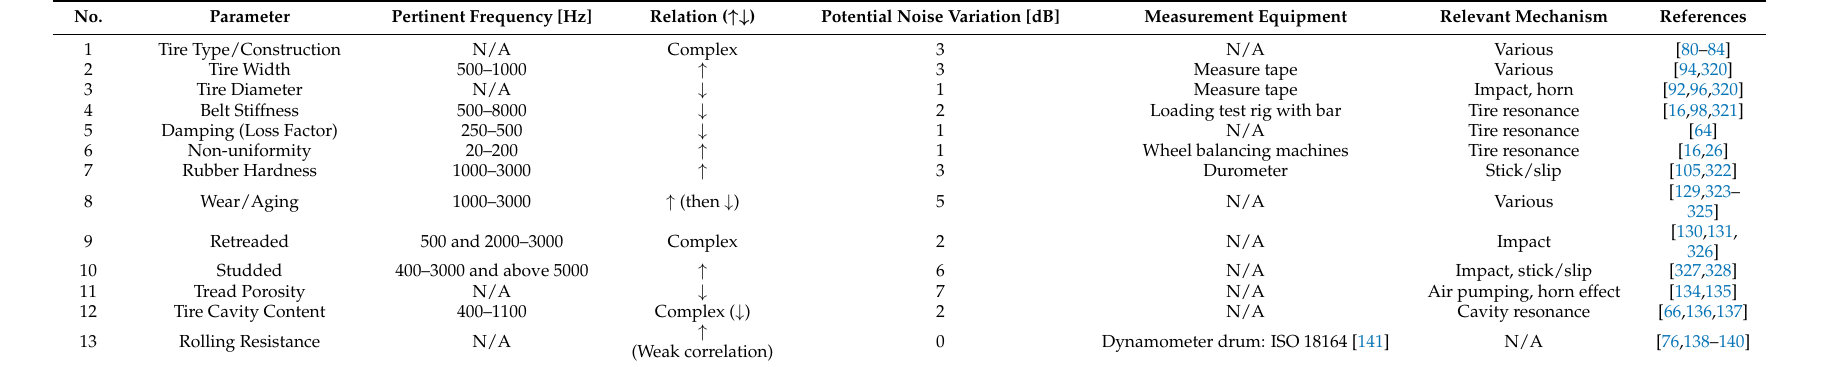
Table 16. Summary of tire-related parameters affecting